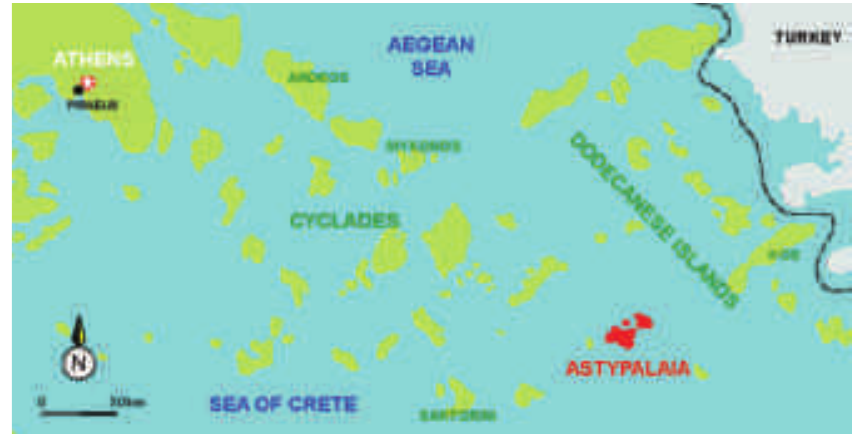
Figure 1 Map showing location of Astypalaia